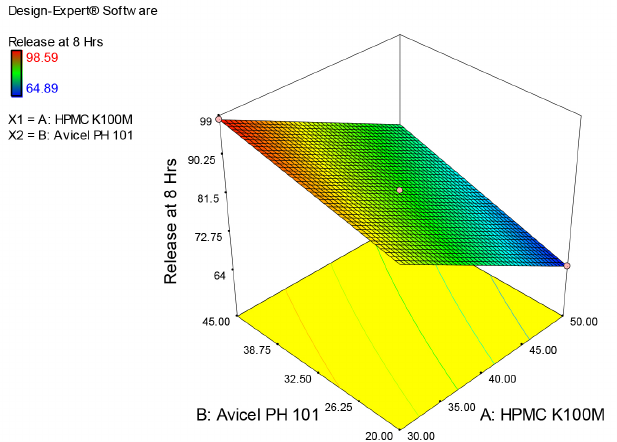
FIGURE 7b - Response surface model (RSM) showing effect of independent variables Ethocel 10FP and Avicel pH 101 on Drug release in 2 hours.